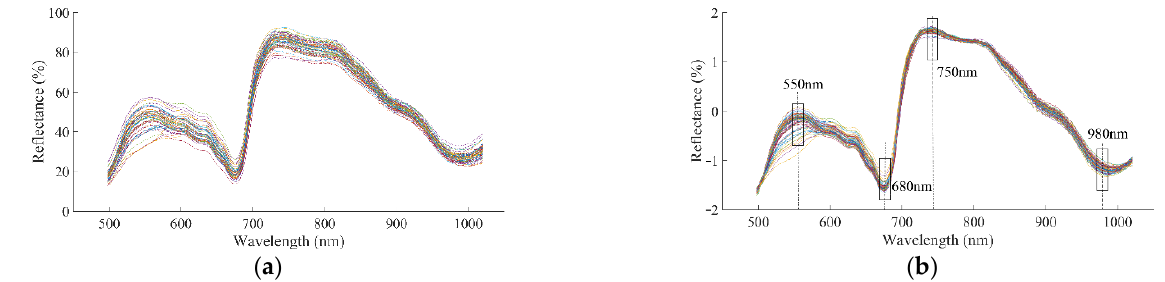
Figure 2. Reflective spectral curves. ( a ) Raw spectrum; ( b ) spectrum after SNV pretreating. Table 2. Correlation coefficients of Cs and Vs with different S-G parameters.